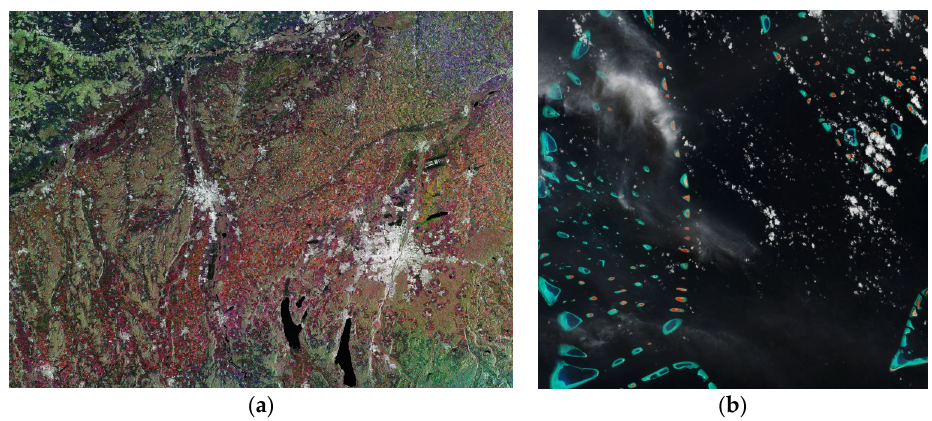
Figure 8. Test images “Southern Bavaria” ( a ) and “Jewels of the Maldives” ( b ).